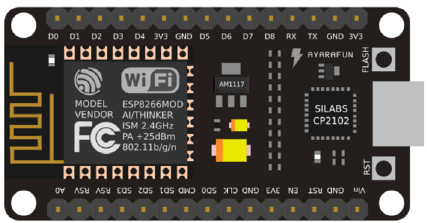
Figure 10. ESP8266 Wi-Fi communication module.